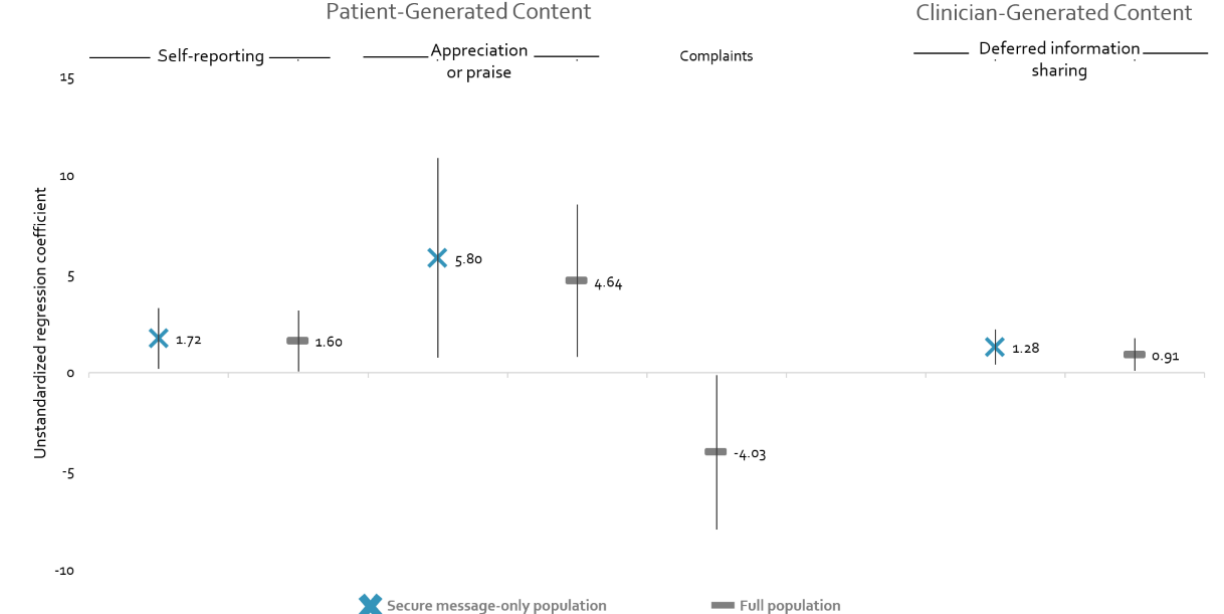
Figure 2. Associations between taxa and SBP changes. SBP: systolic blood